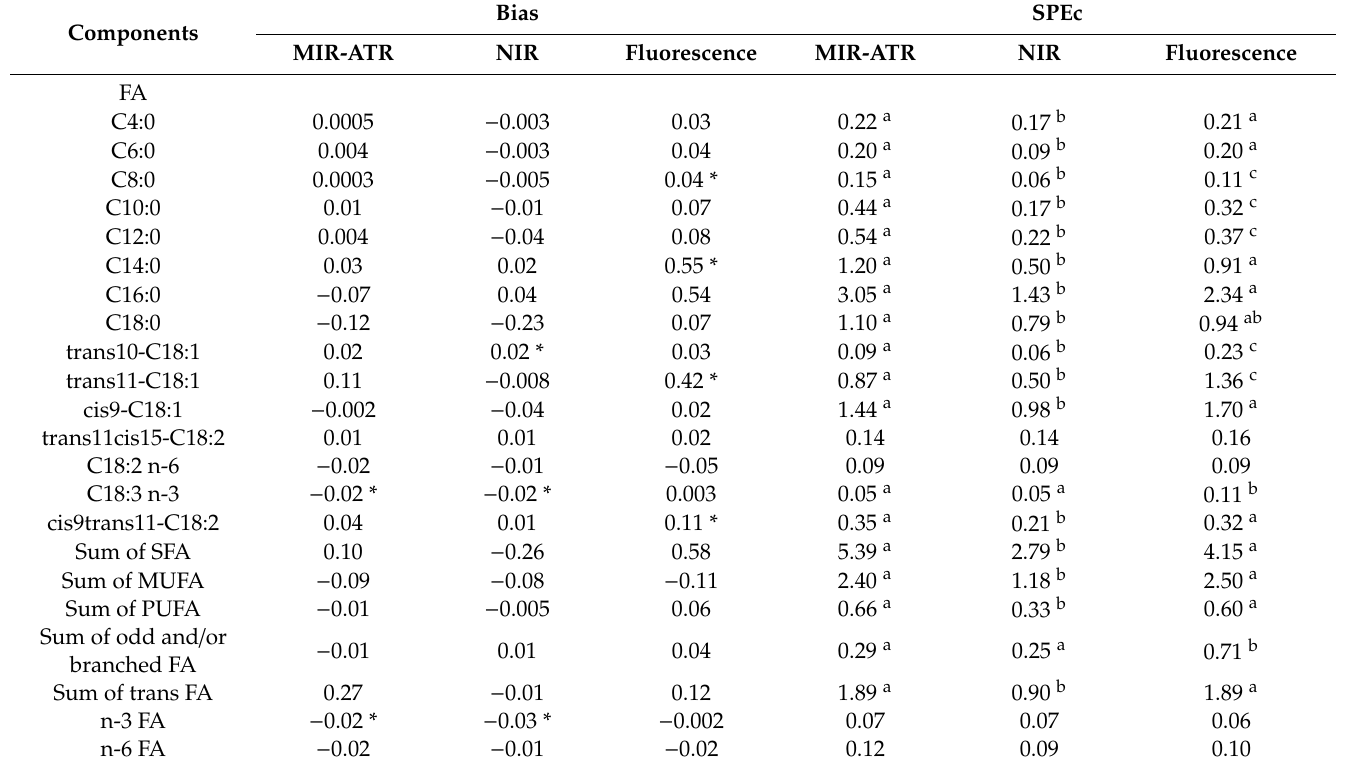
Table A3. Bias and standard error of prediction corrected for bias (SEPc) for selected milk fatty acids (FA, expressed in g fat / kg of milk) obtained when each sample of validation set was predicted using calibration equation selected according to the spectroscopy technique: mid-infrared using an Attenuated Total Reflectance cell (MIR-ATR), near-infrared (NIR) and